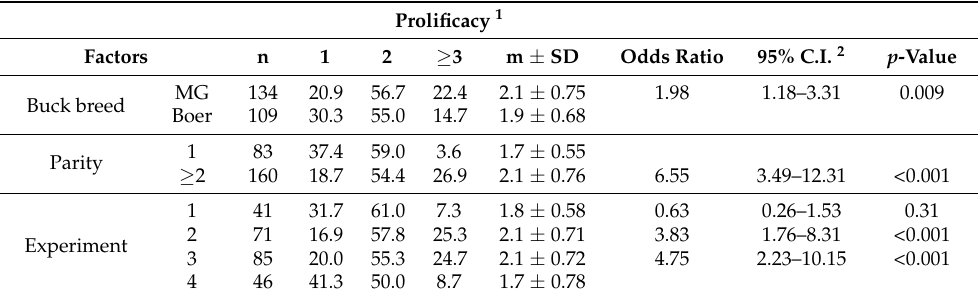
Table 5. Means and odds ratios of the factors included in the final logistic regression model for pro- lificacy (kids born/parturition) in Murciano-Granadina (MG) goats (primiparous and multiparous) mated with Boer bucks (n = 12) or MG bucks (n = 12) in 4